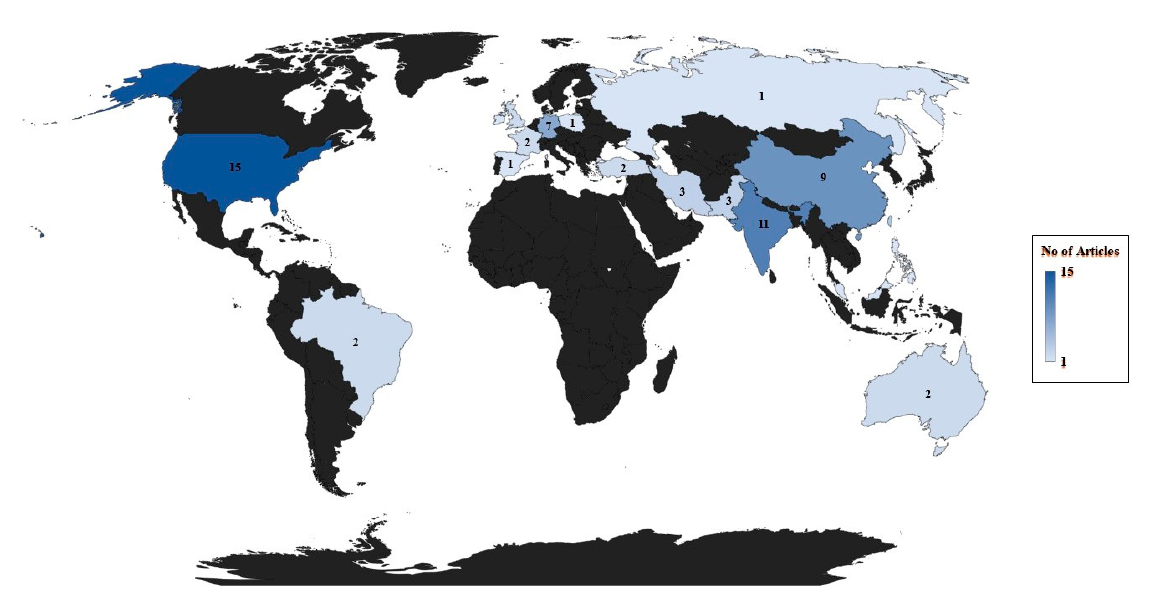
Figure 6. Articles classified by country of origin.